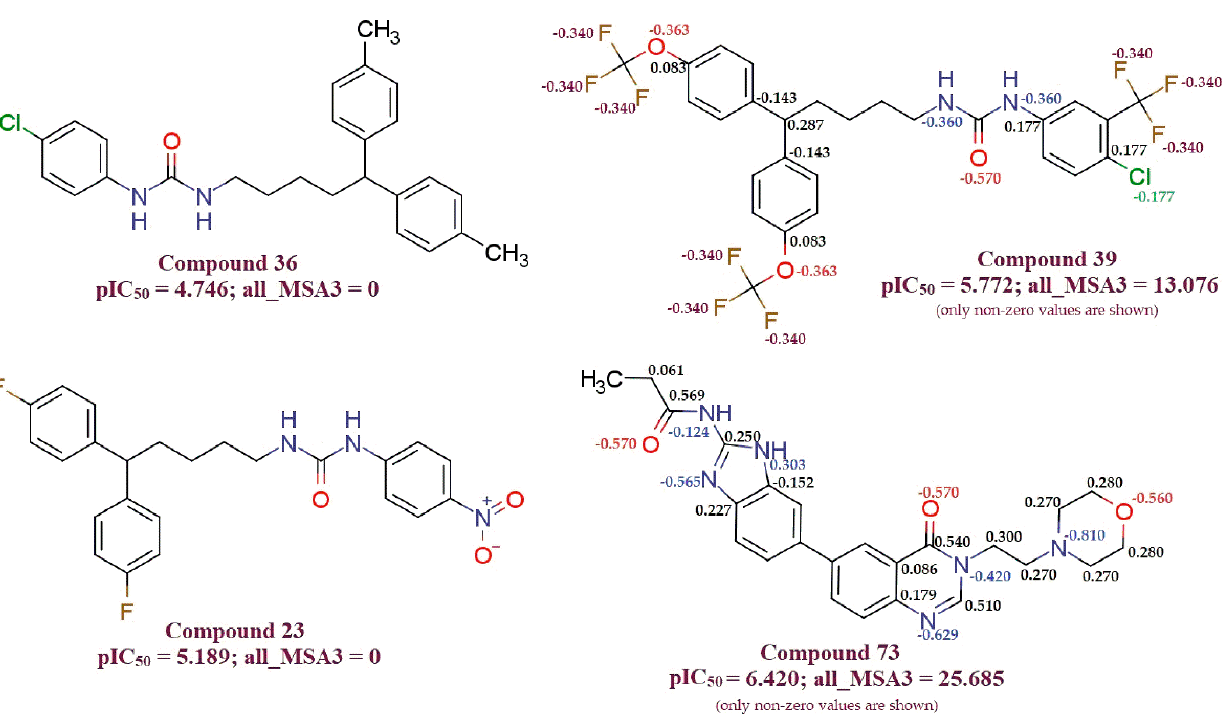
Figure 2. Illustration for molecular descriptor all_MSA3 .